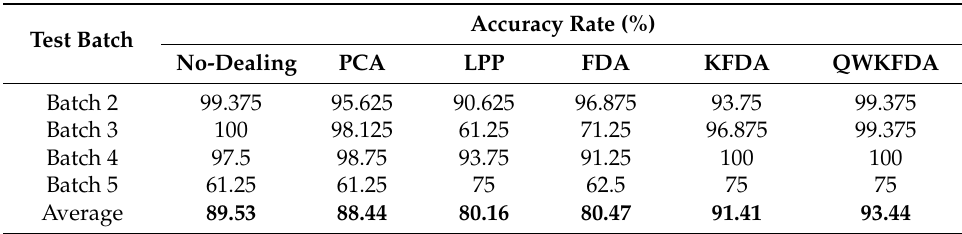
Table 5. The performance of different control